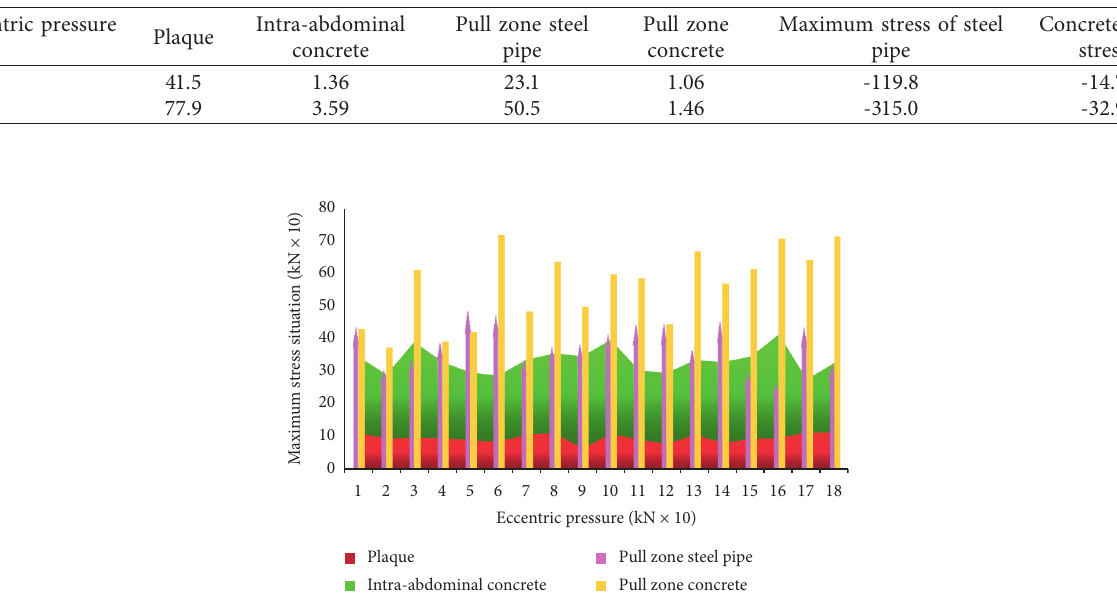
Table 6: Stress distribution of plaques and related parts.